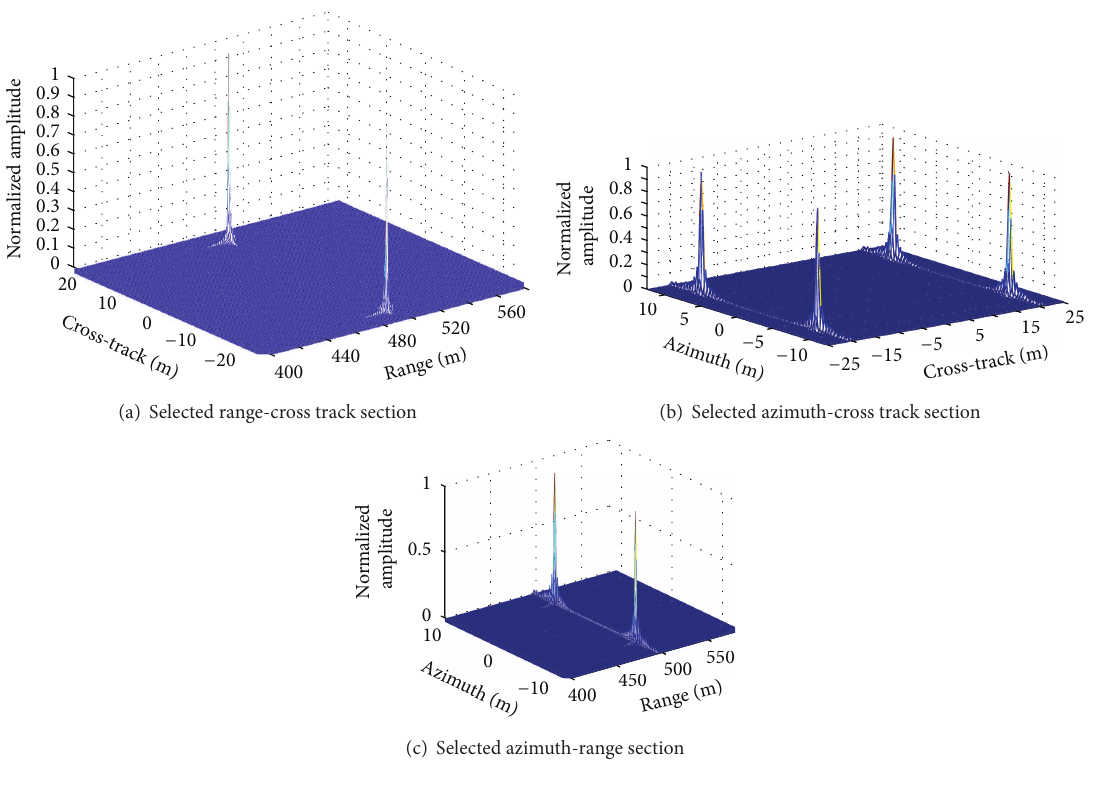
Figure 5: 2D image of selected